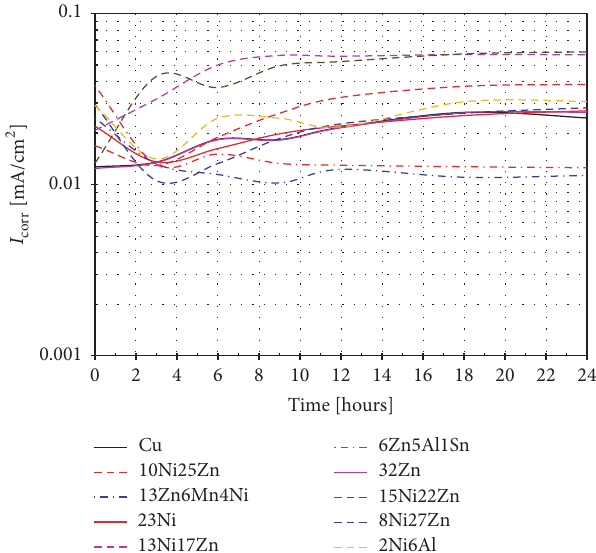
Figure 11: 𝐼 corr variation against time for Cu-based coins evaluated in artificial sweat at 37 ∘ C ( 𝐼 corr values from 𝑅 ct values of EIS